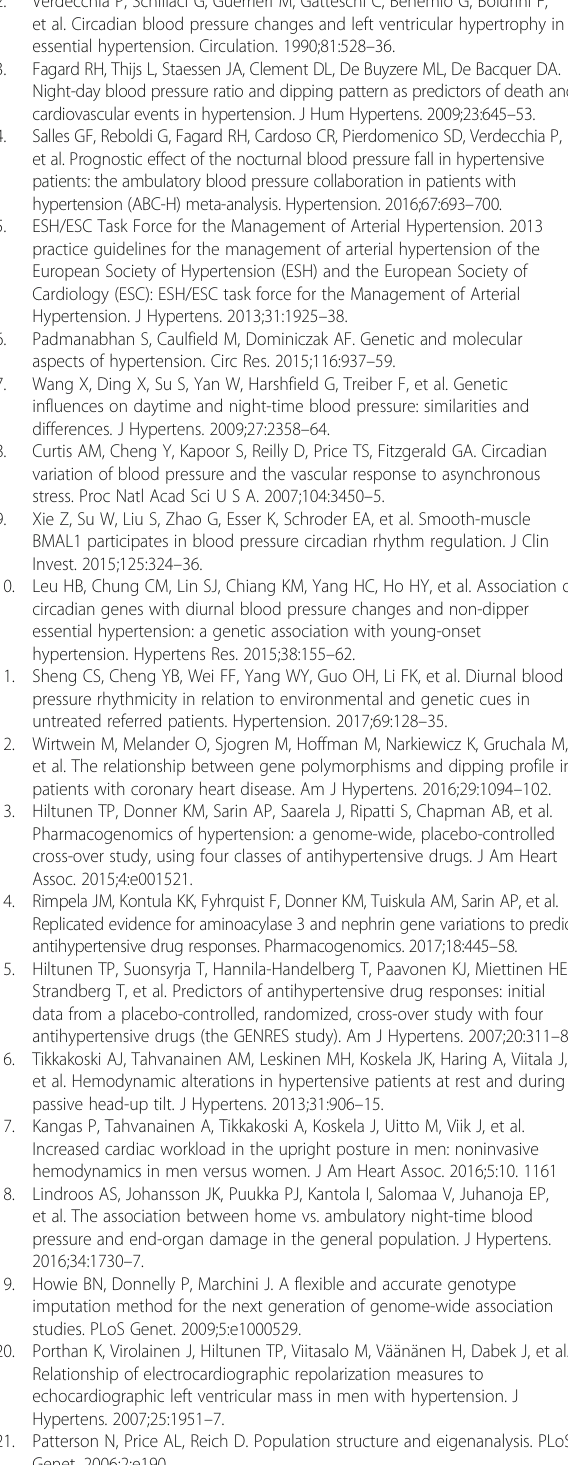
Additional file 4: Figure S3A-F. LocusZoom plots of the top loci for blood pressure dipping. (DOC 591 kb) Additional file 5: Figure S4A-F. Systolic and diastolic blood pressure dipping (night-to-day blood pressure ratio) during placebo and drug treatment periods according to top six SNPs genotypes in GENRES. (DOC 457